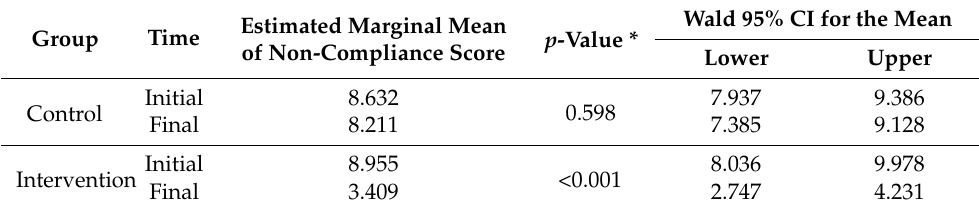
Table 2. Comparation of estimated marginal means of non-compliance ergonomic postures, according to group and time.